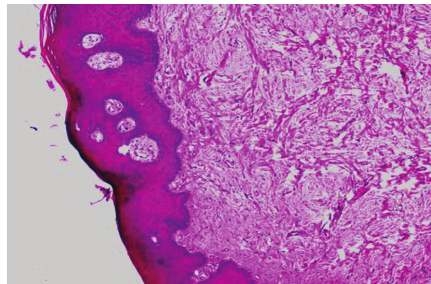
Figure 5: Histopathological view of the excised specimen shows stratified squamous epithelium with proliferating rete ridges; con- nective tissue showing abundant plump and proliferating fibroblasts that are spindle shaped forming a network. Few endothelial lined blood vessels are also observed (H&E, 10x).